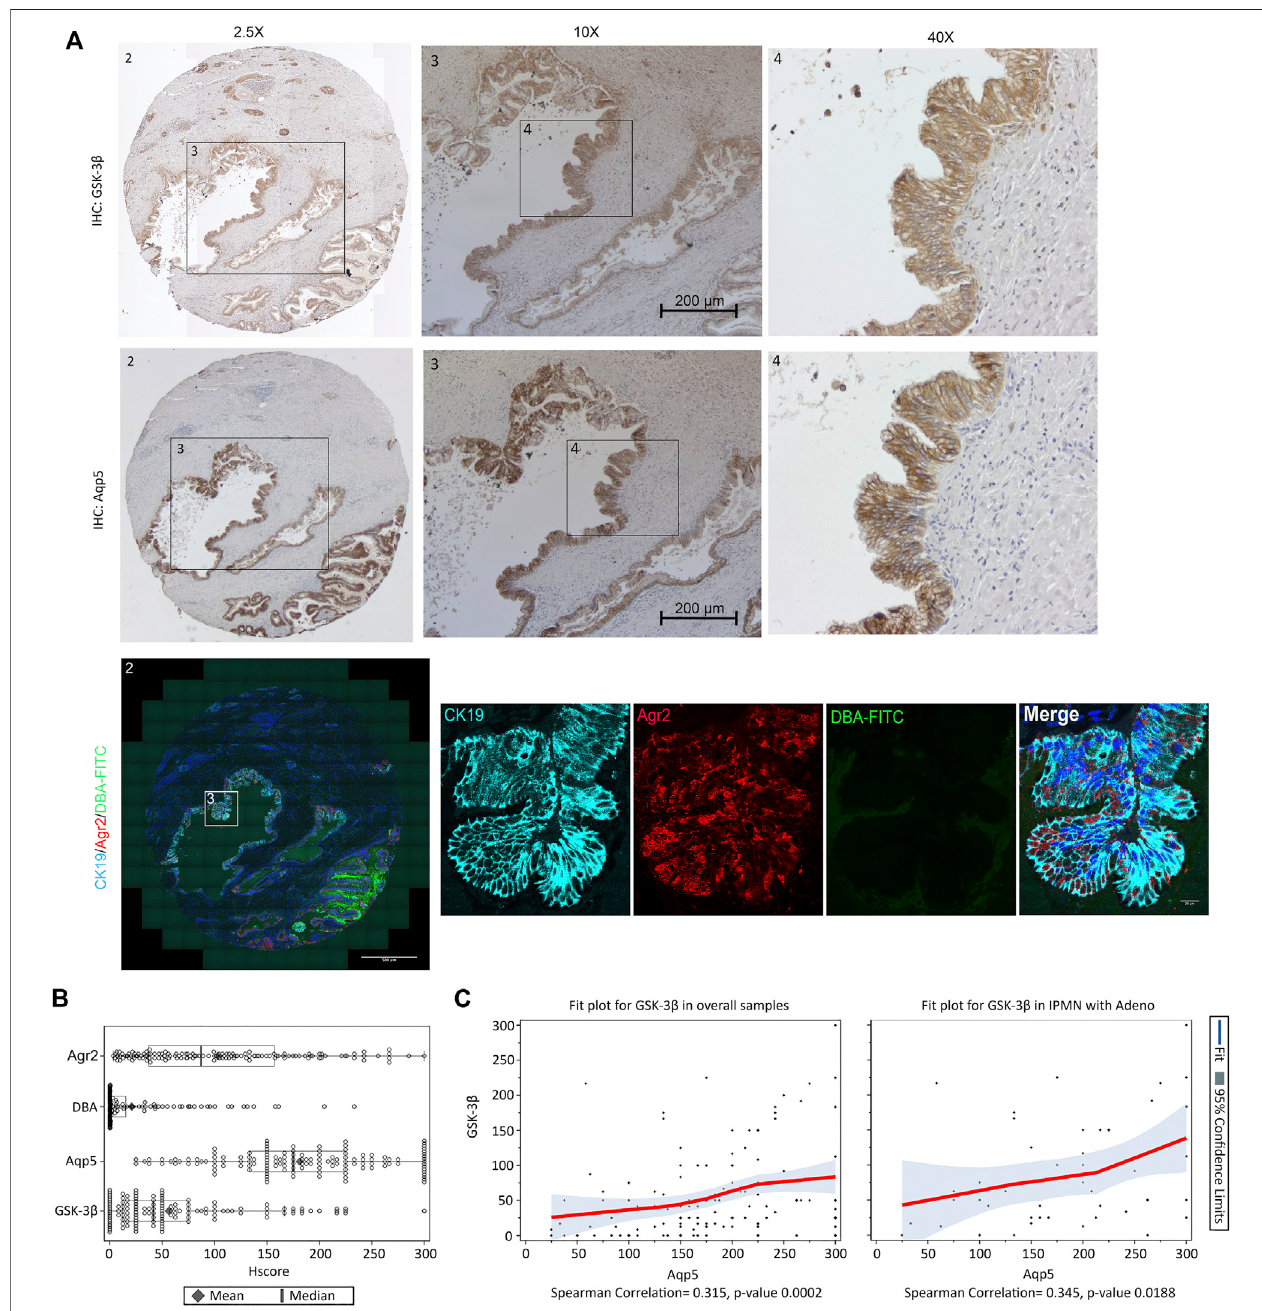
FIGURE 6 | Aqp5, GSK-3 β and Agr2 but not DBA staining is enriched in human IPMN. (A) Representative immunohistochemistry staining of GSK-3 β (Top), Aqp5 (Middle), and immuno fl uorescence stainingof Agr2 (red) with DBA-FITC (green) and CK19 (cyan) (Bottom) from serial sections of the same human IPMN sample. Bars = 200 μ m. (B) Histological score (Hscore) of Aqp5, GSK-3 β , Agr2 and DBA staining in 140 samples of human IPMN were calculated and graphed. The mean ± SD is shown. Black diamond: Mean value. Black line: Median value. (C) Scatter plot with loess fi t line and 95% con fi dence limits (colored area) for Aqp5 and GSK-3 β in overall samples (left) and IPMN with adenocarcinoma (right) were drawn and Spearman correlation coef fi cient were calculated with p -value.